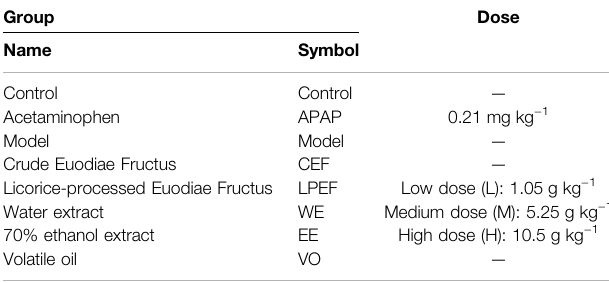
TABLE 1 | Groups and doses of experimental